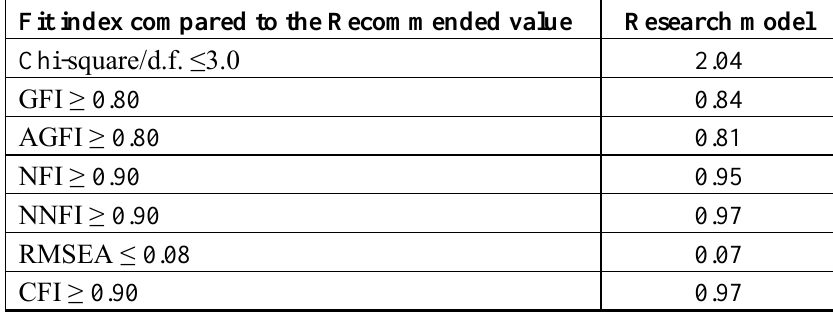
Table 4. Analysis of the goodness-of-fit of the overall